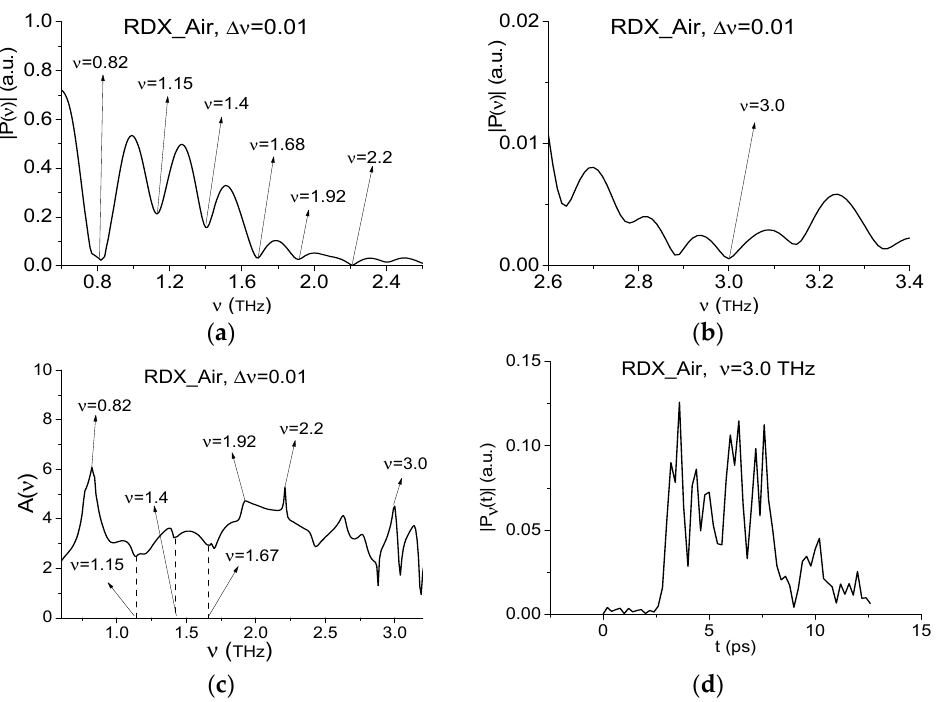
Figure 8. Spectrum ( a ), ( b ) and absorbance (c) of the standard signal RDX_Air depicted in the frequency ranges ν = [0.6, 2.6] THz ( a ), [2.6, 3.4] THz ( b ), and [0.2, 3.2] THz ( c ). Time-dependent evolution of the spectral intensity at the frequency ν = 3.0 THz ( d ).